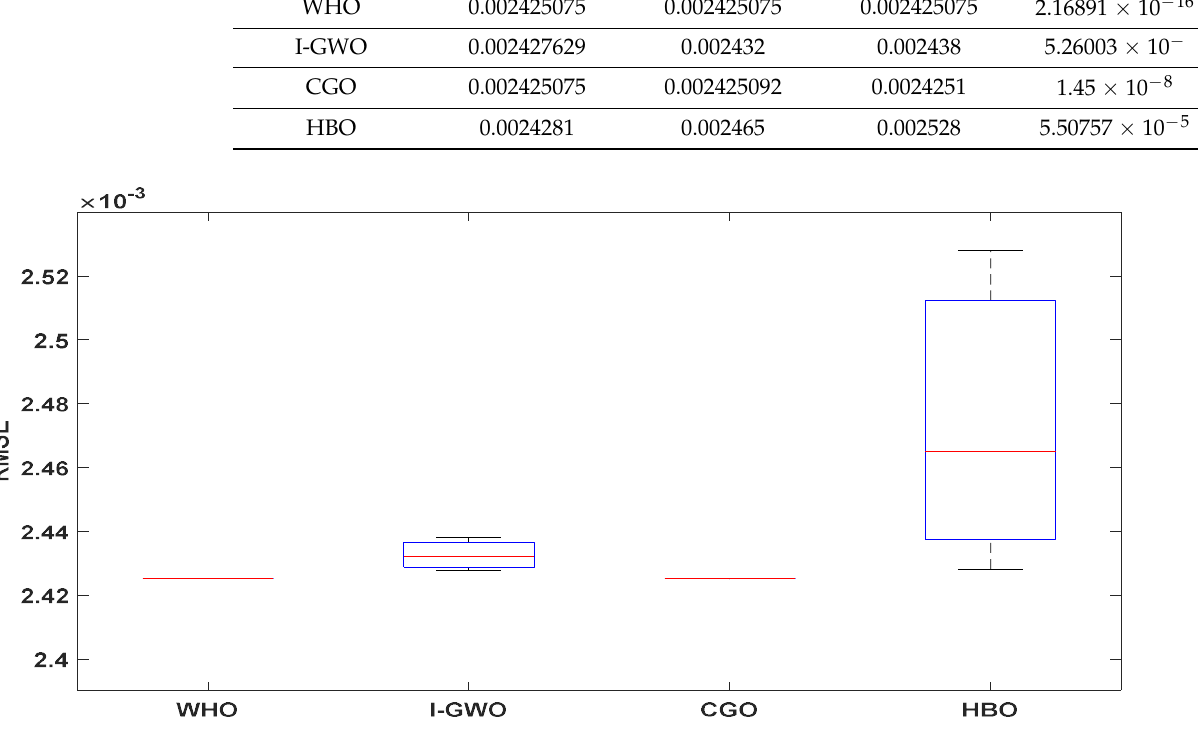
Figure 19. Boxplot for all algorithm for 30 independent runs.